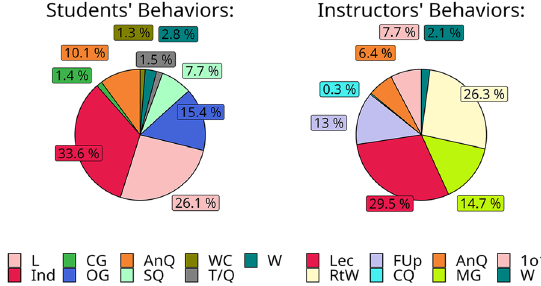
Fig. 3 Pie charts demonstrating the distribution of the COPUS behaviors over the observed problem-solving